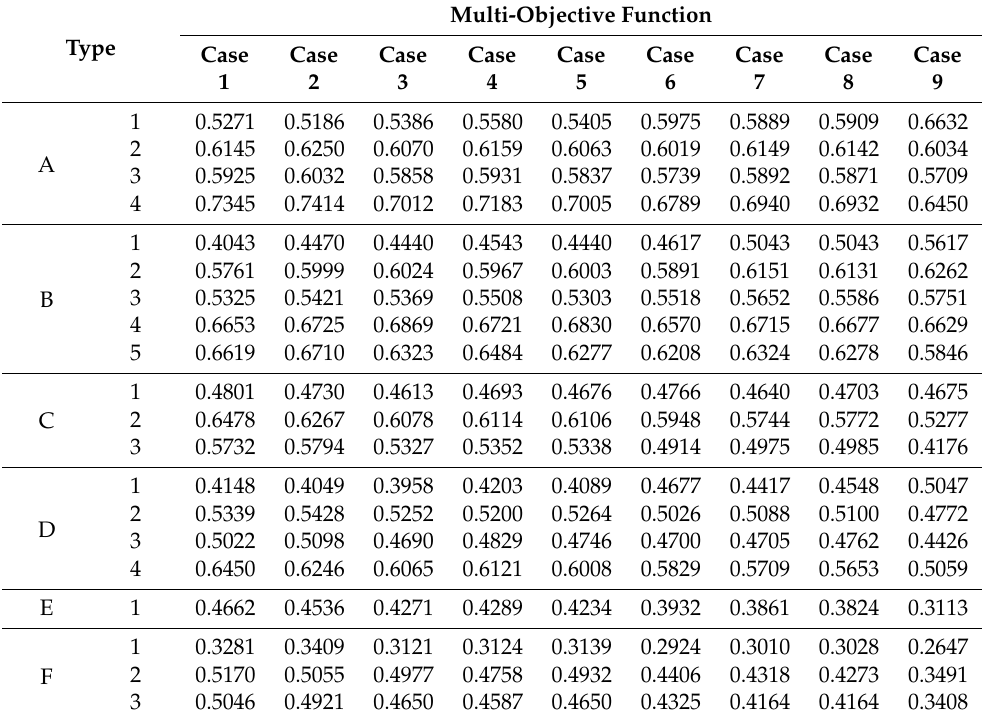
Table 5. Objective functions of the corrugated steel sandwich